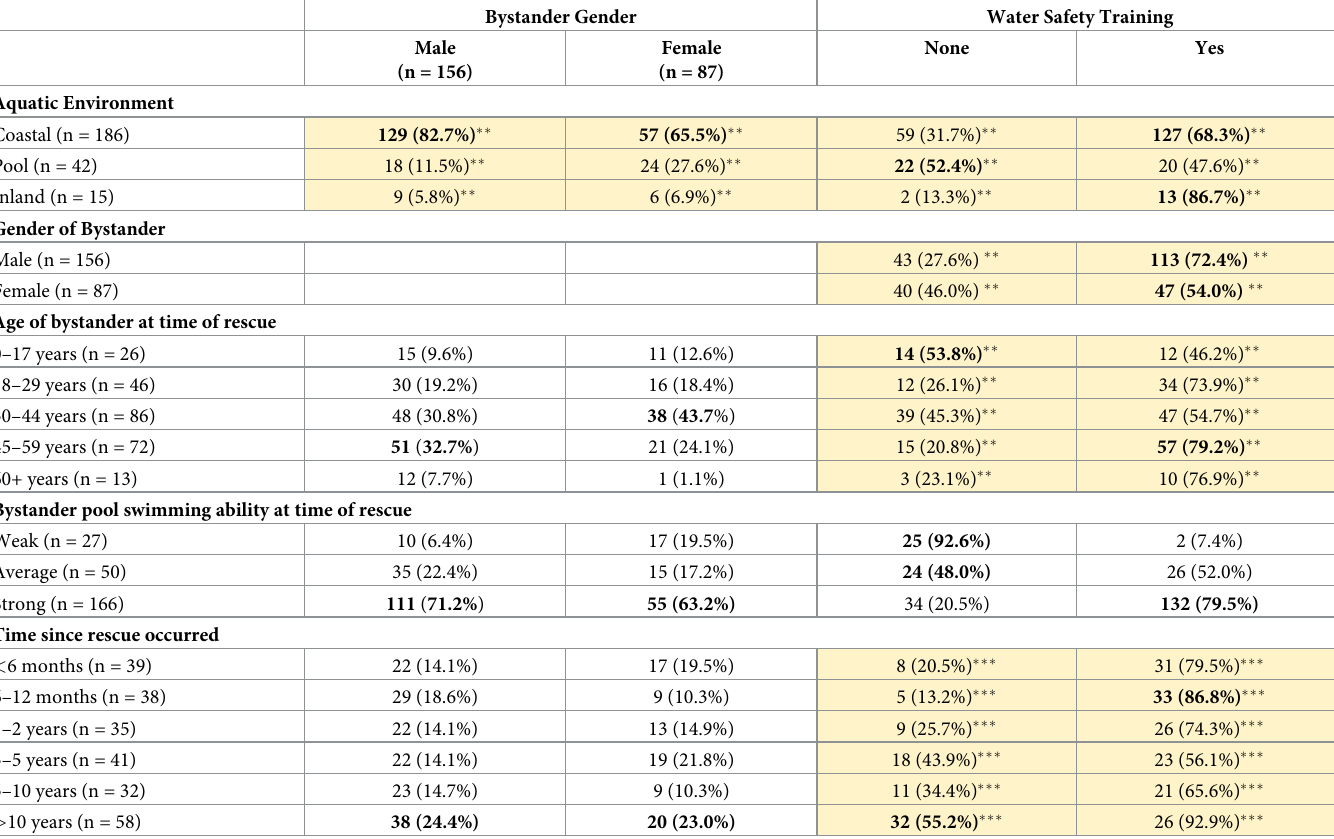
Table 3. Details about the bystander and their most recent rescue. Values and percentages under the ‘Water Safety Training Column’ are based on sample sizes shown in left hand column (with the exception of ‘Gender of Bystander’). Values in bold represent maximums for relevant categories. Shaded areas were found to be statistically significant. Asterisks represent the significance level of the relationship, where � = p � 0.05; �� = p � 0.01 and ��� = p �